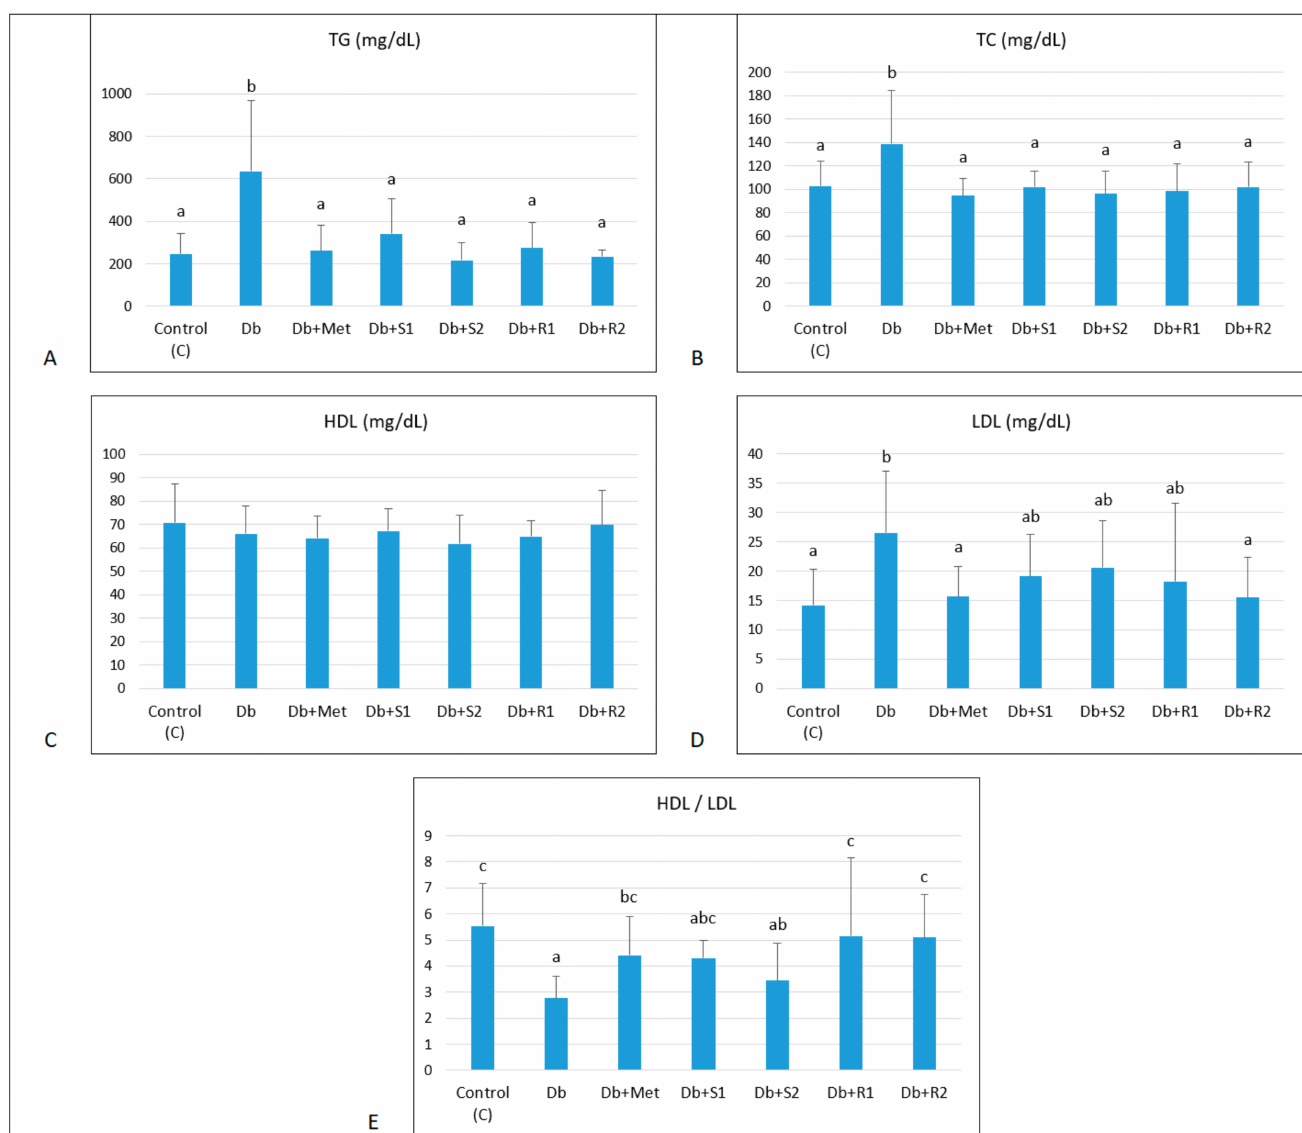
Figure 2. Effect of diet and supplementary SGs on lipid profile indices of rats. ( A ) TG: serum triacylglycerols, ( B ) TC: serum total cholesterol, ( C ) HDL: serum high-density lipoproteins, ( D ) LDL: serum low density lipoproteins and ( E ) HDL/LDL ratio in serum of experimental rats. Data are presented as mean ± standard deviation (M ± SD). Values with different letters (a–d) show statistically significant differences ( p < 0.05, a < b, Fisher’s LSD